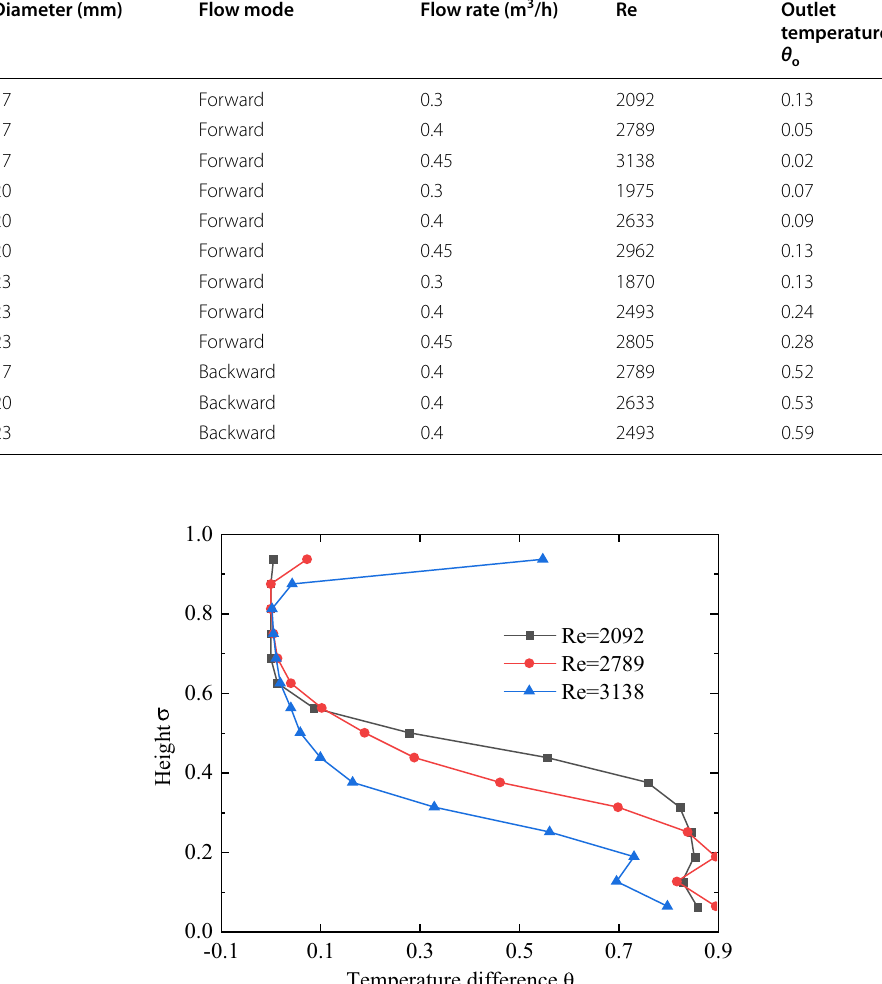
Table 2 Summary of the experimental conditions and results Diameter (mm)